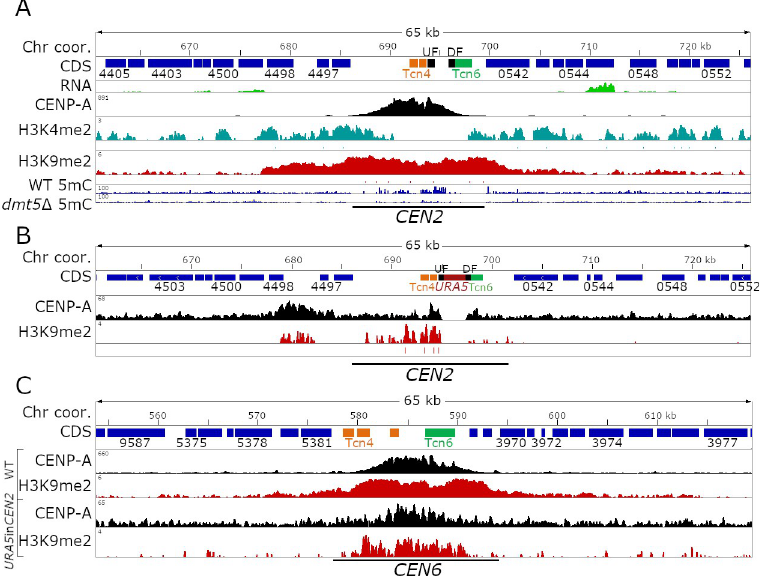
Fig 4. Insertion of a transgene into a native centromere shifts the CENP-A binding. For all three panels, a detailed centromeric view (65 kb) of CEN2 or CEN6 is shown. Chromosome coordinates are shown on top, CDS are shown in blue, and truncated transposable elements are indicated with their family color. ChIP-seq is shown in black (CENP-A), turquoise (H3K4me2, only wild-type), and red (H3K9me2). UF and DF indicate the 5’ and 3’ region used for homologous recombination. (A) Detailed view of native centromere 2. In addition to the ChIP-seq data, bisulfite sequencing data to analyze 5mC enrichment is shown. (B) Detailed view showing CENP-A and H3K9me2 enrichment in the URA5 insertion strain. The URA5 gene is shown in red. (C) Enrichment level across CEN6 are shown as control for both ChIP-seq experiments which revealed that one experiment showed better enrichment than the other, albeit in the same